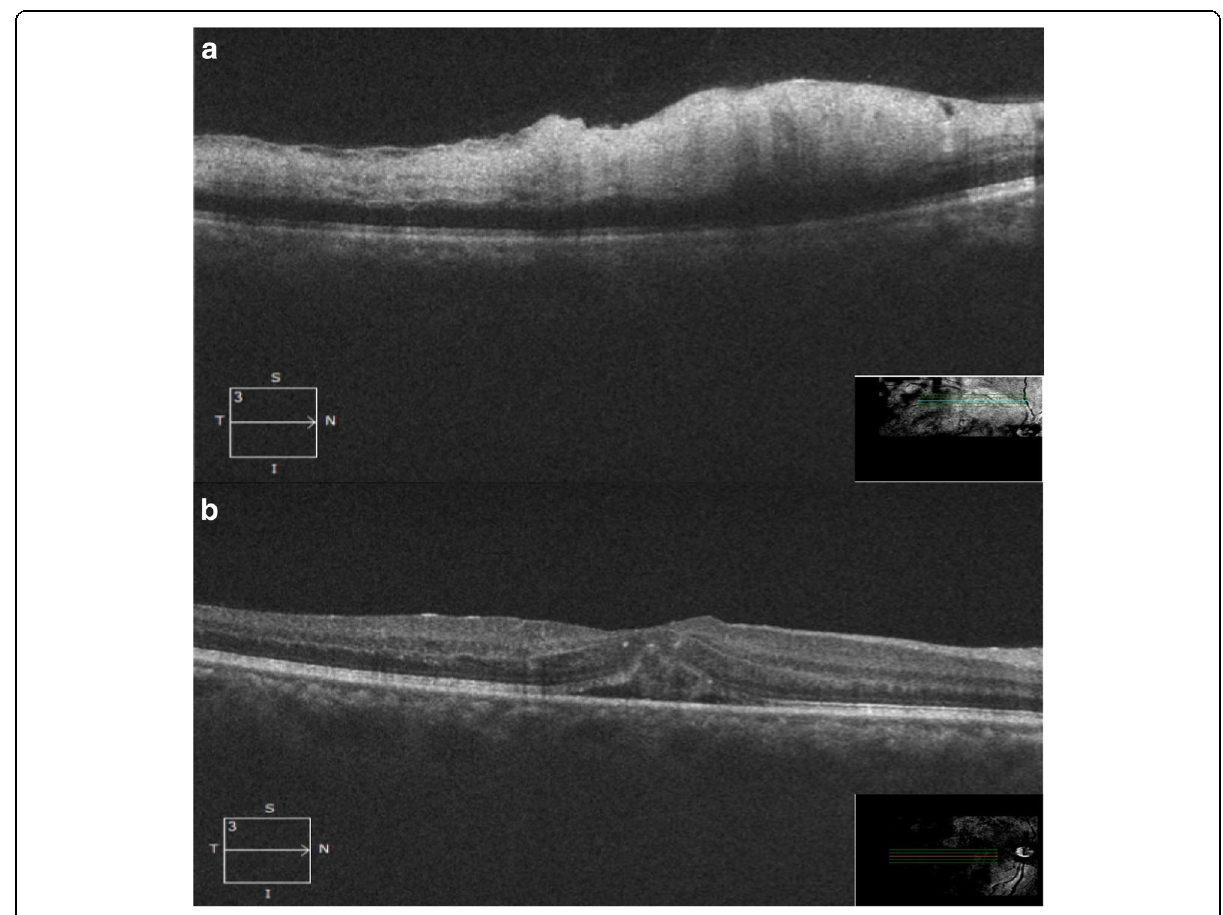
Fig. 2 OCT (at presentation): raster scan ( a ) through the lesion showing hyperreflectivity with loss of distinct architecture and increased thickness the inner retinal layers along with sub-ILM fine dot-like deposits. b Through fovea showing loss of foveal contour with neurosensory retinal detachment and sub-foveal